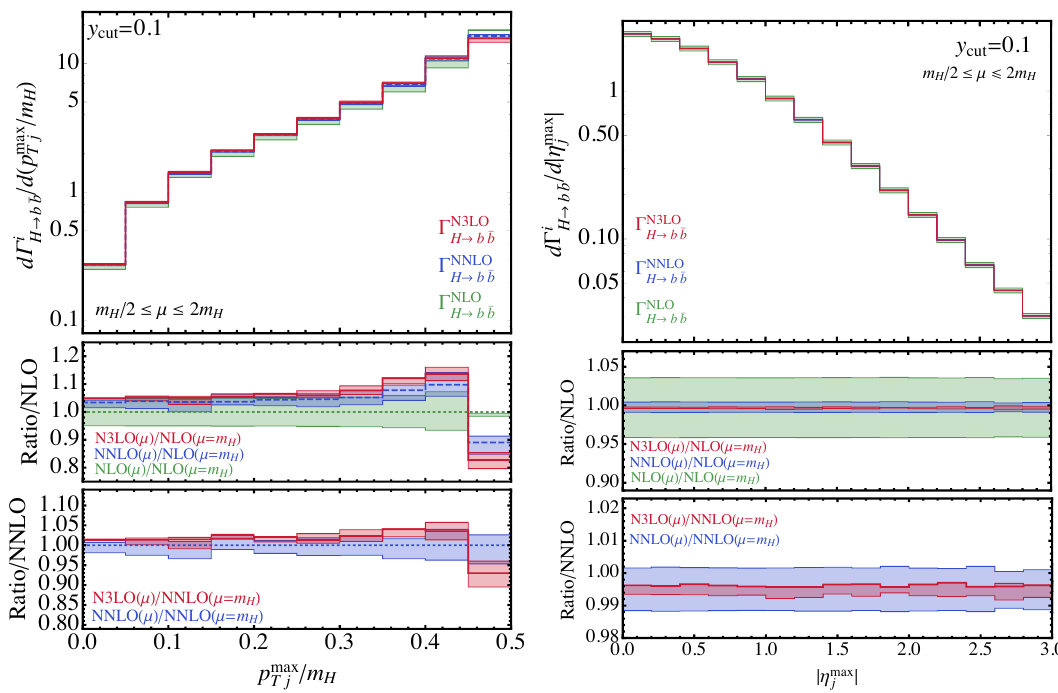
Figure 7 . The ( m H -scaled) transverse momentum and pseudo-rapidity of the maximum-energy jet in the Higgs rest frame at NLO, NNLO, and N 3